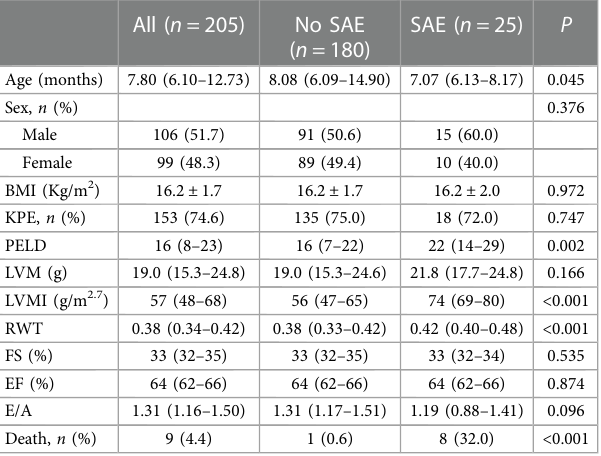
TABLE 1 Baseline characteristics of SAE and No-SAE patients.